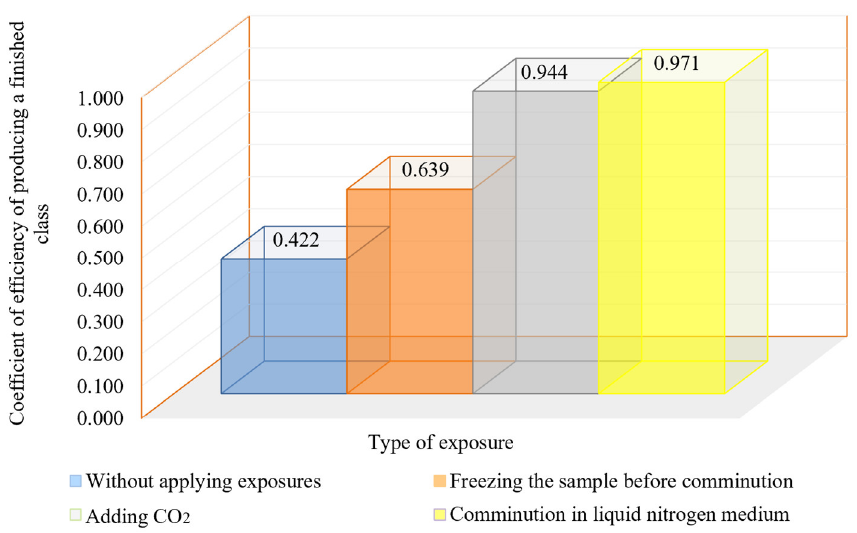
Figure 10. Dependence of the effectiveness ratio of the finished size class working out on the method of cryogenic exposure to ore.